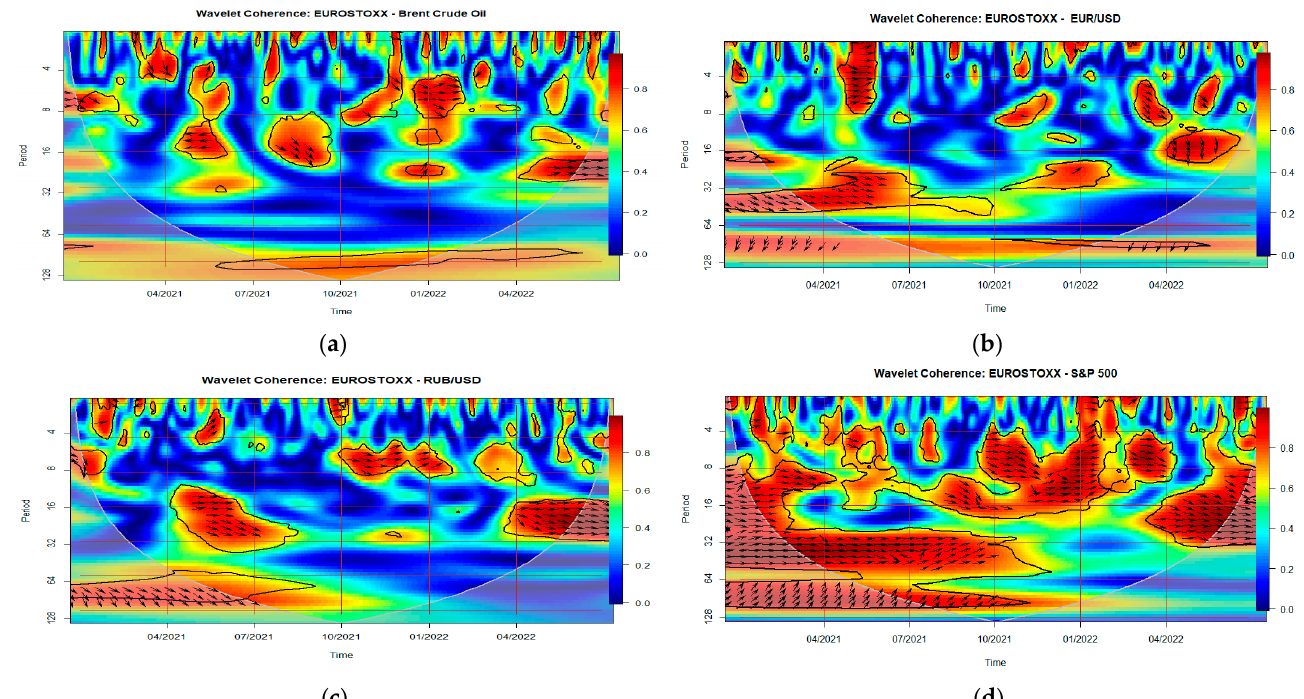
Figure 2. ( a – d ) Wavelet coherence between Eurostoxx and ( a ) Brent crude oil, ( b ) EUR/USD, ( c ) RUB/USD and ( d ) S&P 500. ( c ) RUB/USD and ( d ) S&P